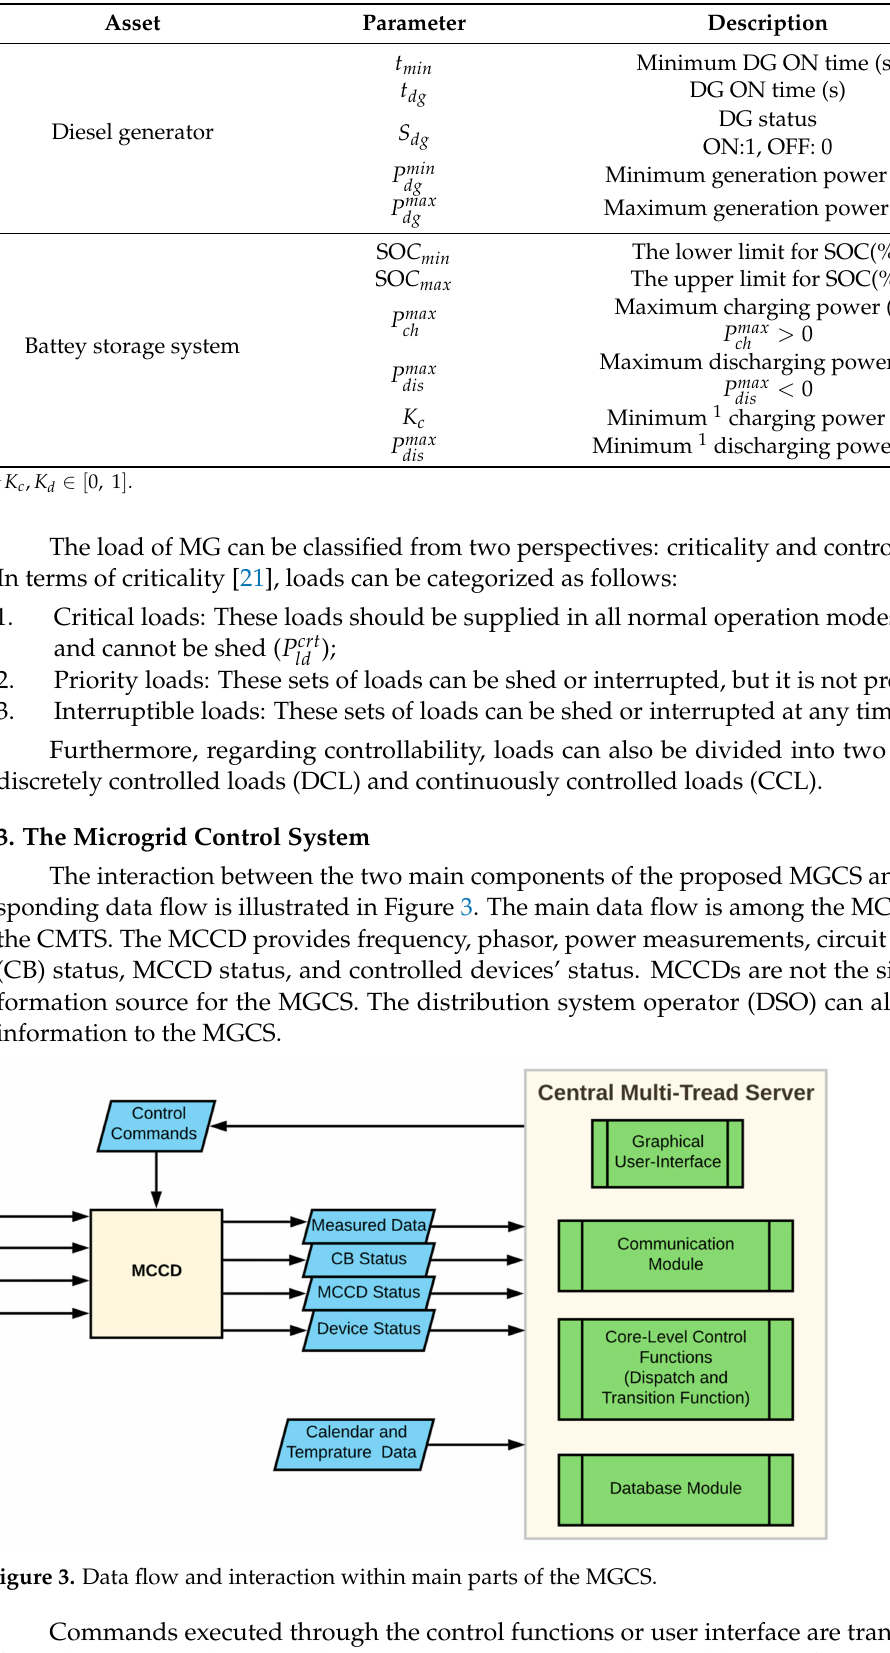
Table 1. The parameters related to DG and BSS.